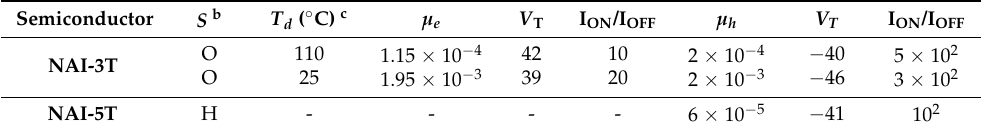
Table 5. OFET electrical data for vapor-deposited films of NAI-3T and NAI-5T measured under vacuum on Si/SiO 2 substrates. Average field-effect mobilities are shown a .